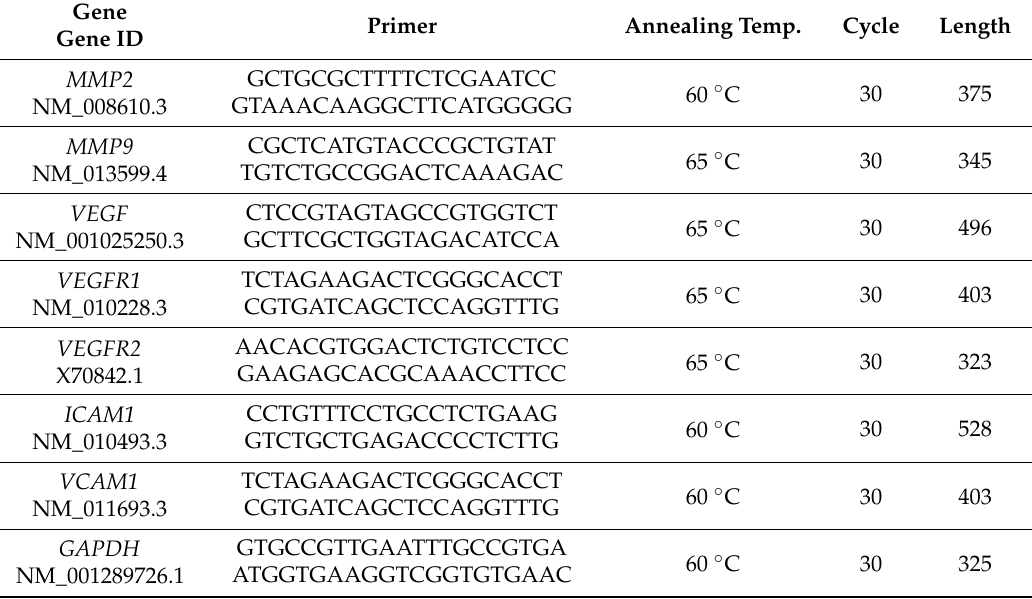
Table 2. Primer information for